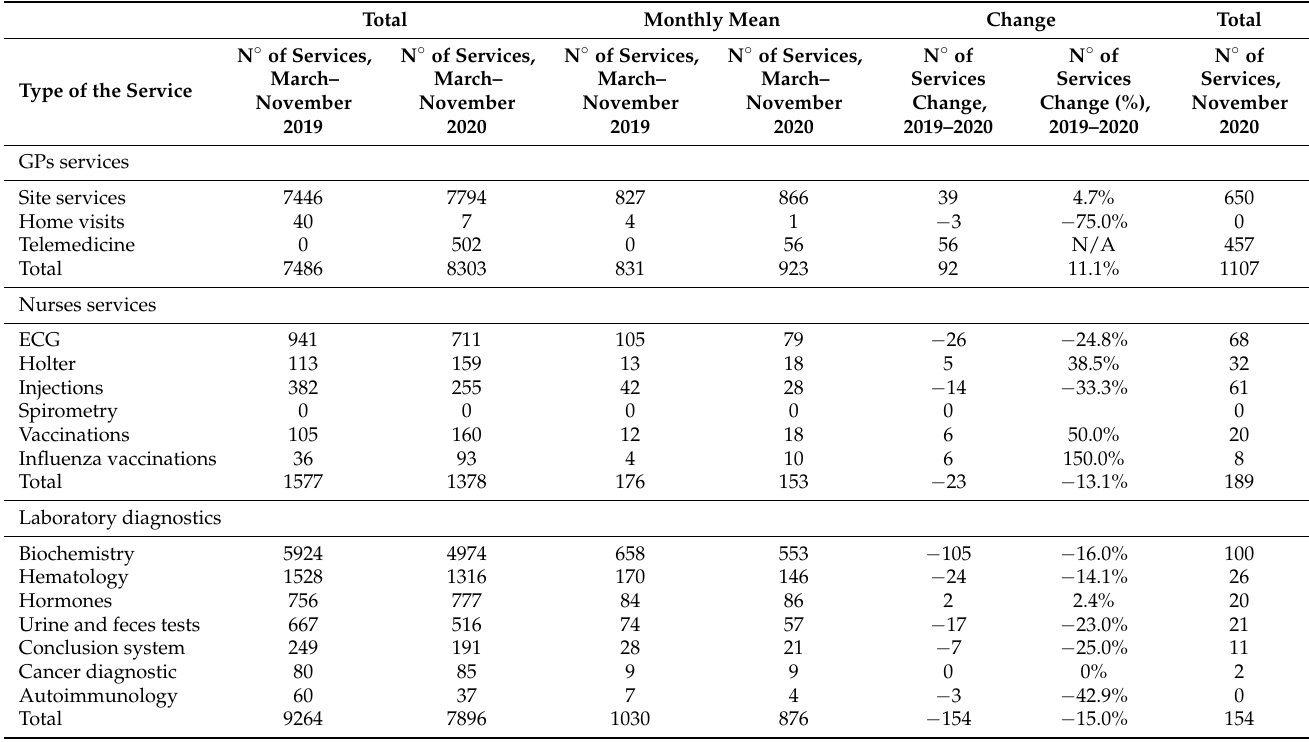
Table 8. Number of services provided by GPs, nurses and the number of laboratory diagnostics provided to the patients